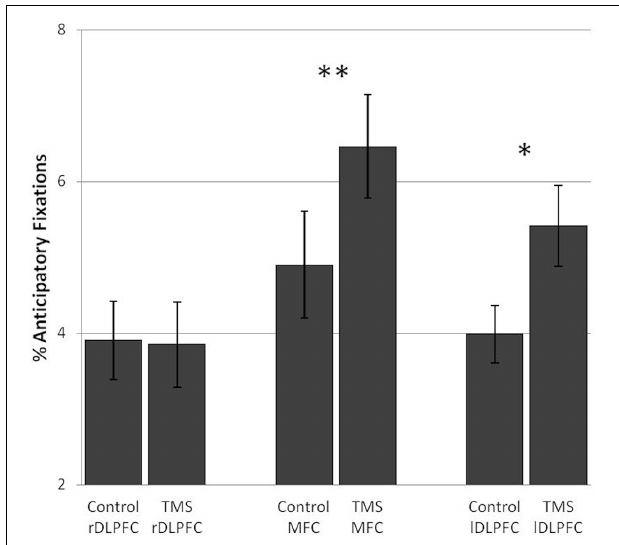
FIGURE 5 | TMS effects on the percentage of regressive fixations in the number and letter search task. Significant differences in regressive fixations between the control and TMS condition were found after stimulation over the left dorsolateral prefrontal cortex. Error bars indicate standard errors of the mean (SE). ∗